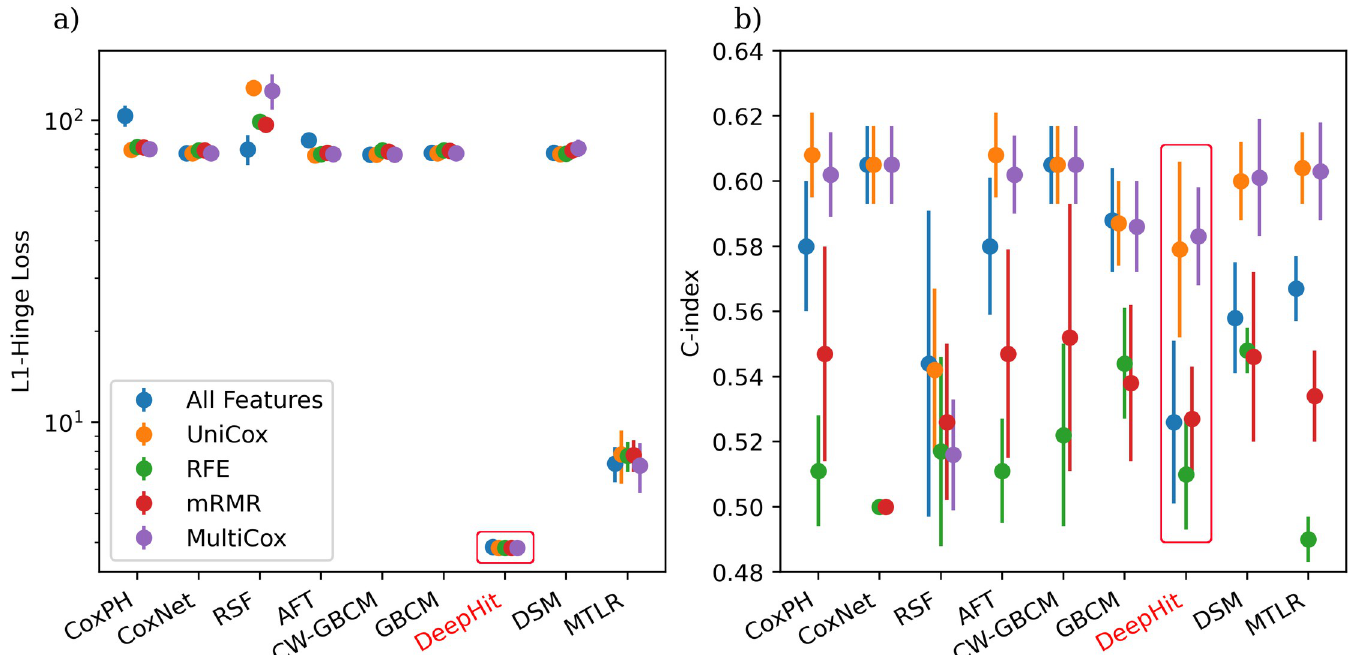
Fig 6. Feature selection method comparison using MICE imputation. The red rectangle boxes represent the non-calibrated models.